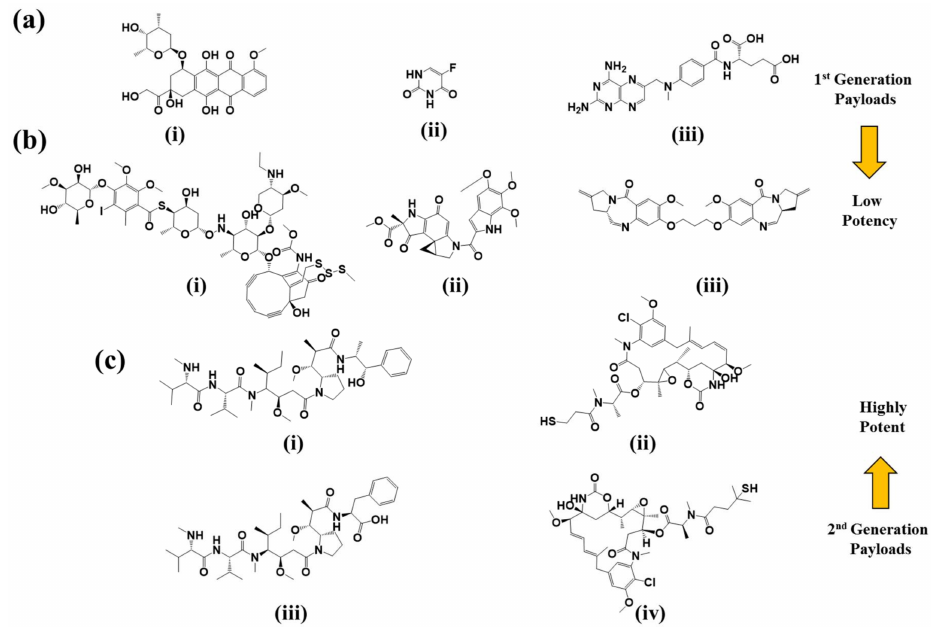
Figure 4. Chemical structures of first and second generation payloads used in ADCs. ( a ) 1st